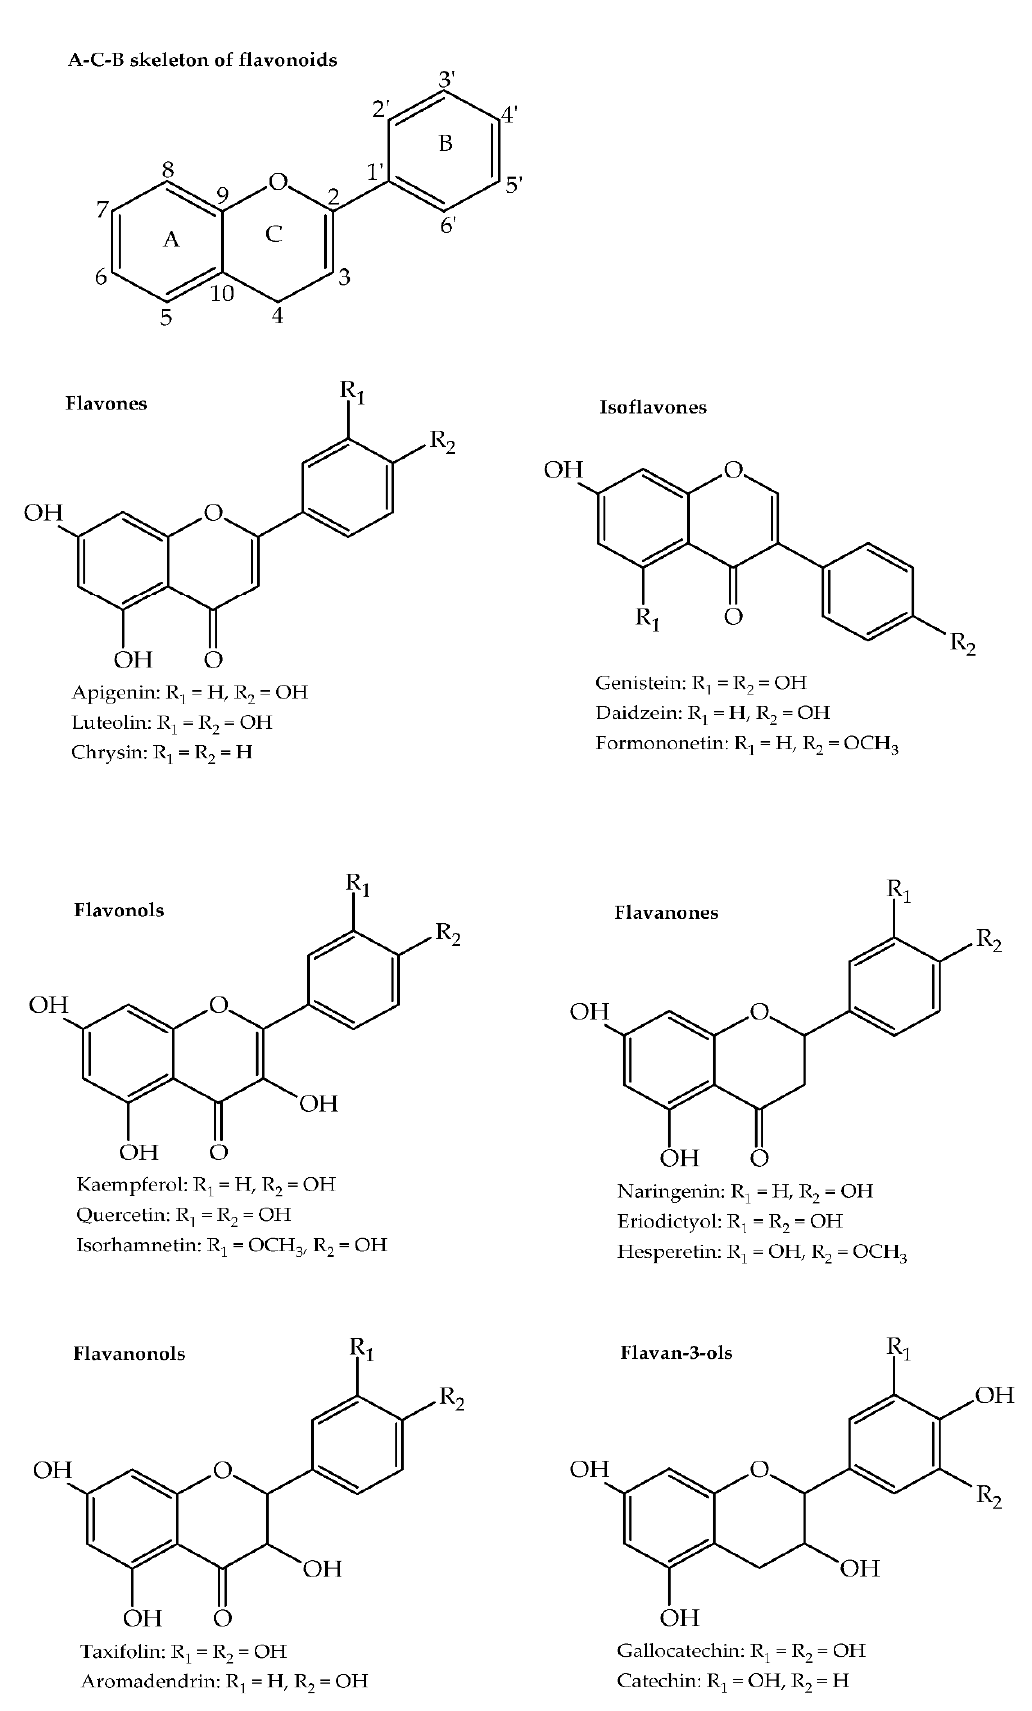
Figure 2. Structures of flavonoids.